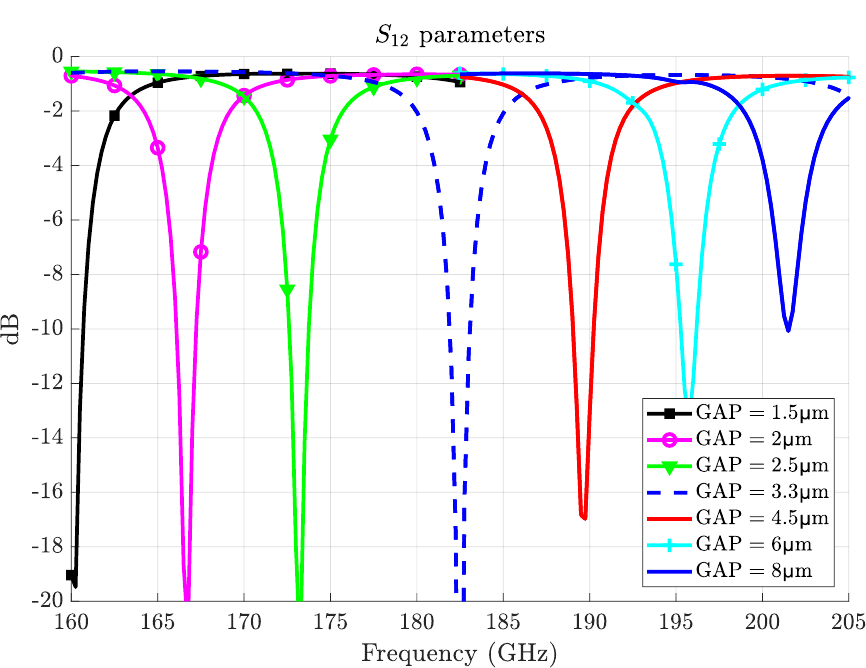
Figure 8. Tuning of the millimeter-wave resonance frequency by using a metallic movable ring.